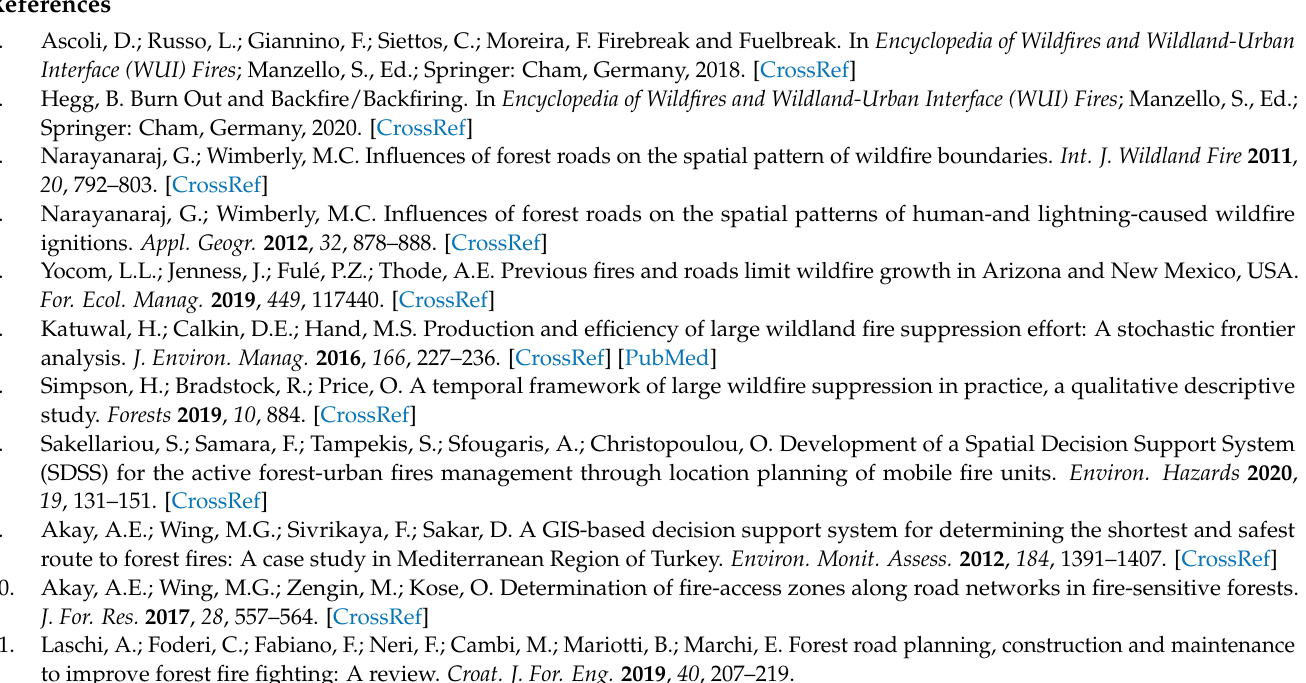
NAVTEQ/HERE road polylines (here.com)